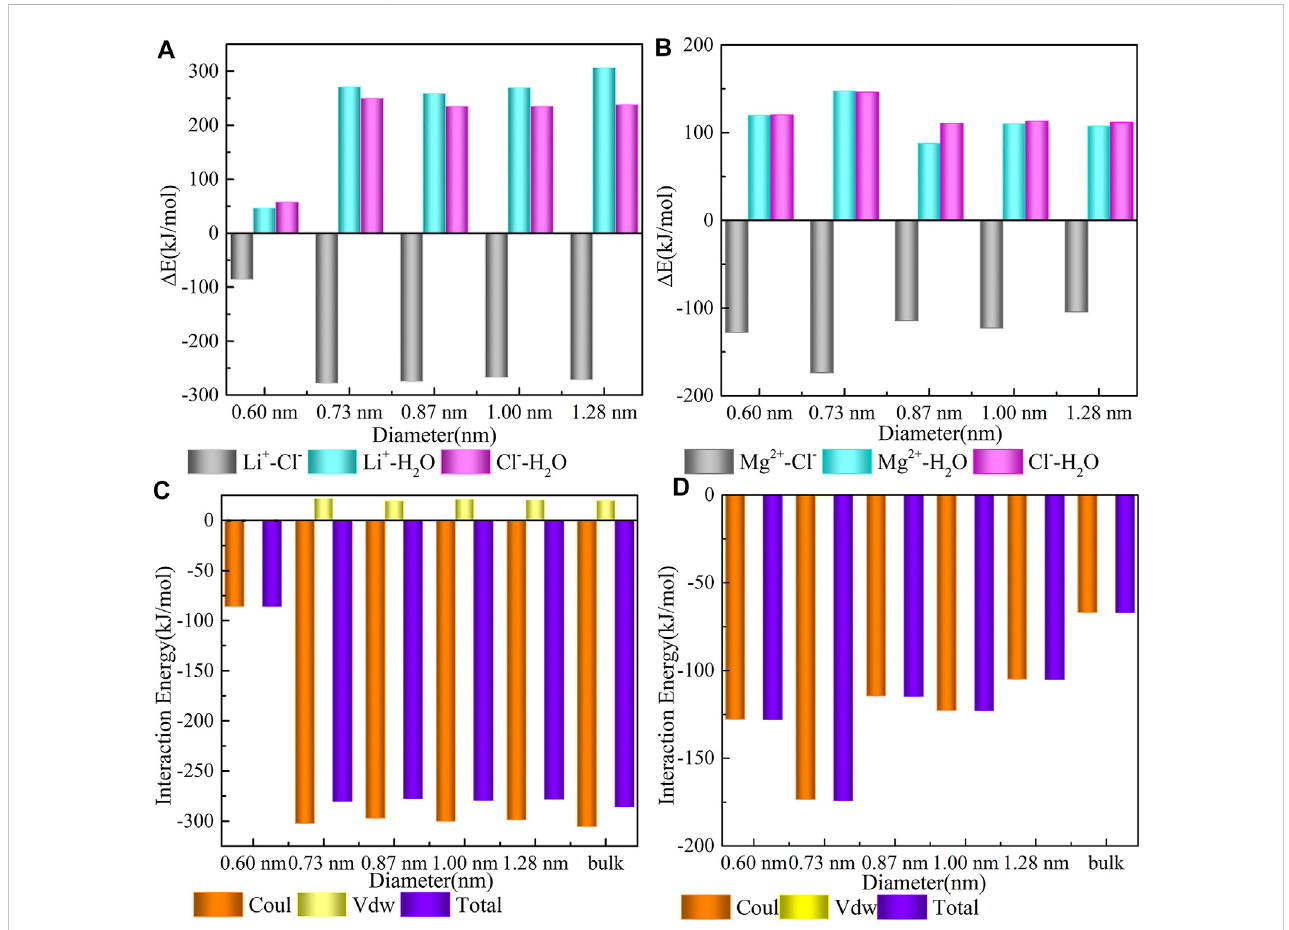
FIGURE 4 Energy details. (A,B) pairwise interaction energies of ions-CNT, cation – water, and anion-water; (C) the interaction between Li + and Cl − ; and (D) the interaction between Mg 2+ and Cl − .